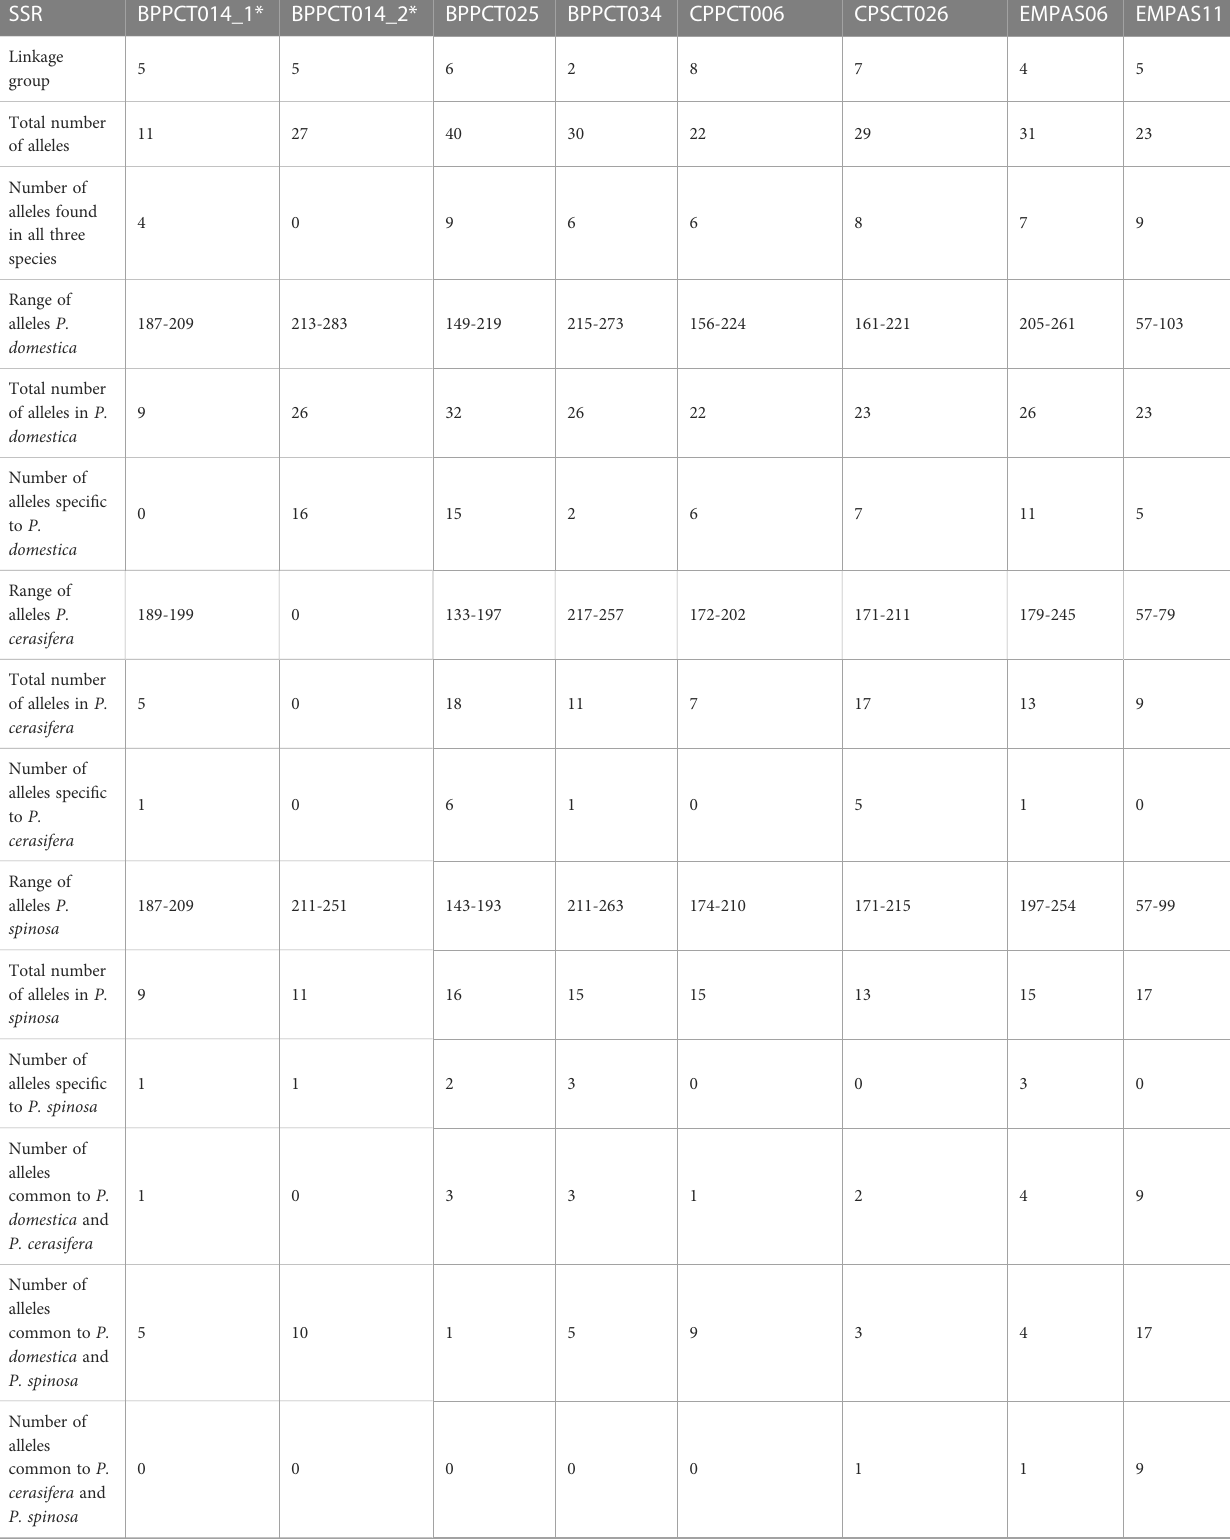
TABLE 2 Distribution of SSR alleles in plum species ( P. domestica , P. cerasifera and P. spinosa ).